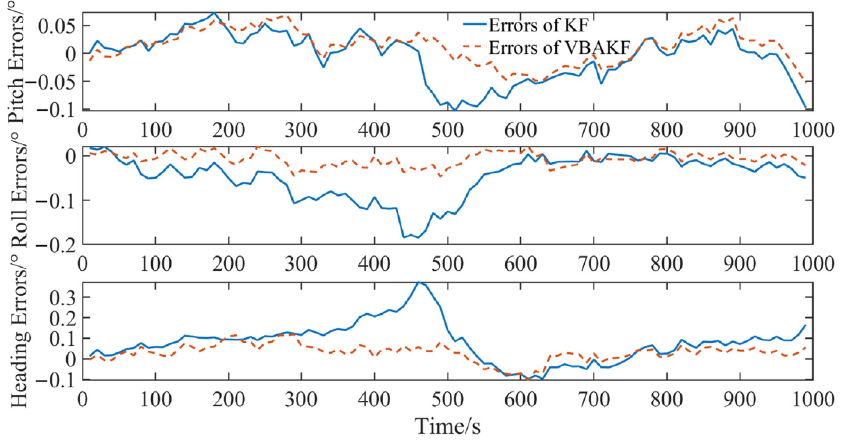
Figure 5. Comparison of filtering results when the measured noise is a random quantity with periodic sinusoidal characteristics.